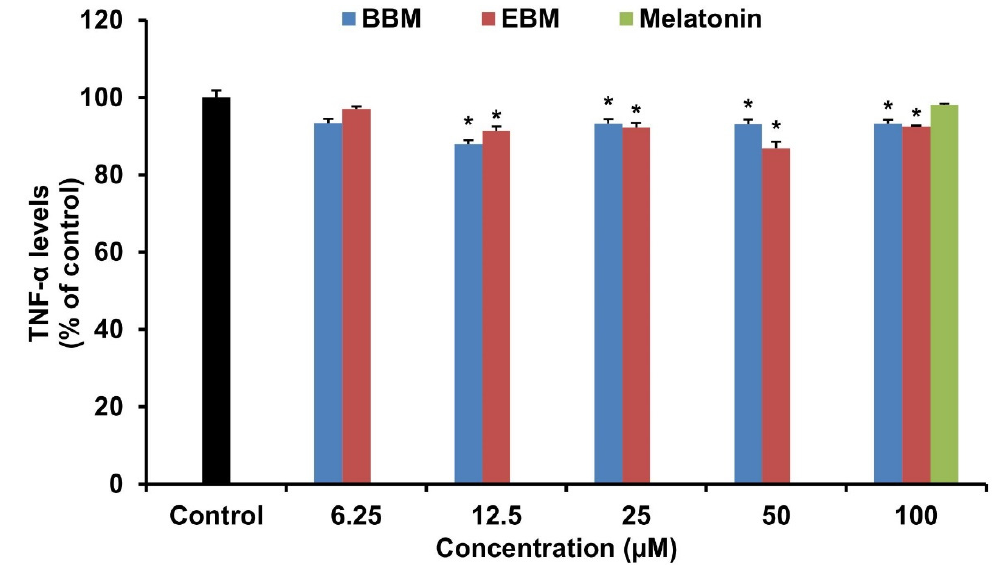
Molecules 2021 , 26 , x FOR PEER REVIEW Figure 5. Effect of melatonin, BBM and EBM on the production of IL-6 in LPS-stimulated RAW 264.7 cells. Values are expressed as the means ± S.E.M * p < 0.05, ** p < 0.001 versus vehicle treatment group, ## p < 0.001 versus melatonin 100 µM.